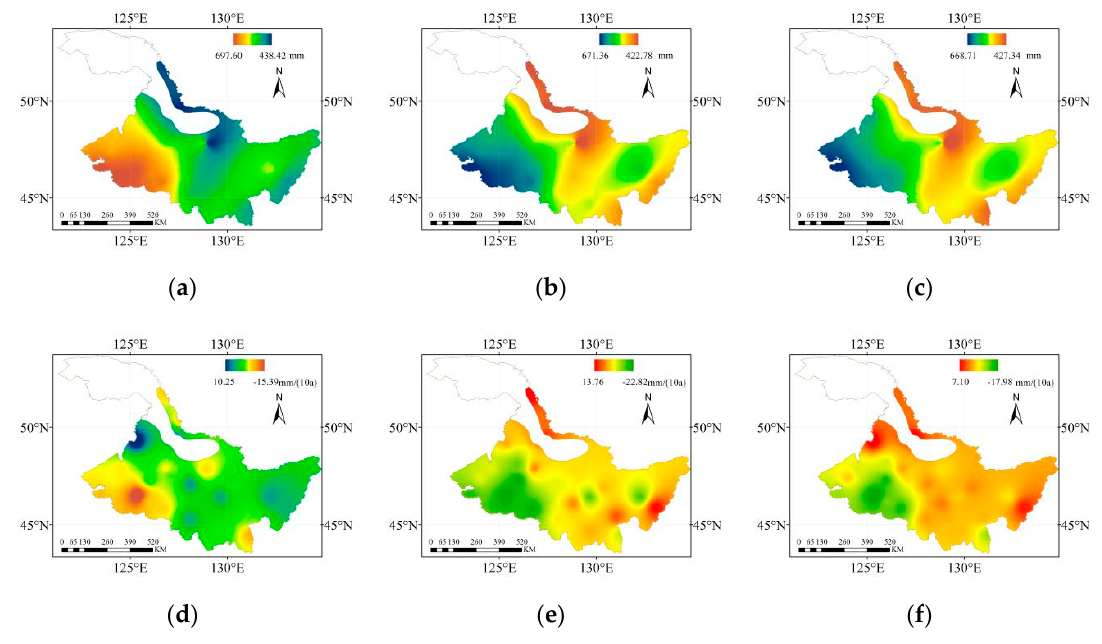
Figure 2. Average annual reference crop evapotranspiration ( ET 0 ) during ( a ) 1960–1979, ( b )